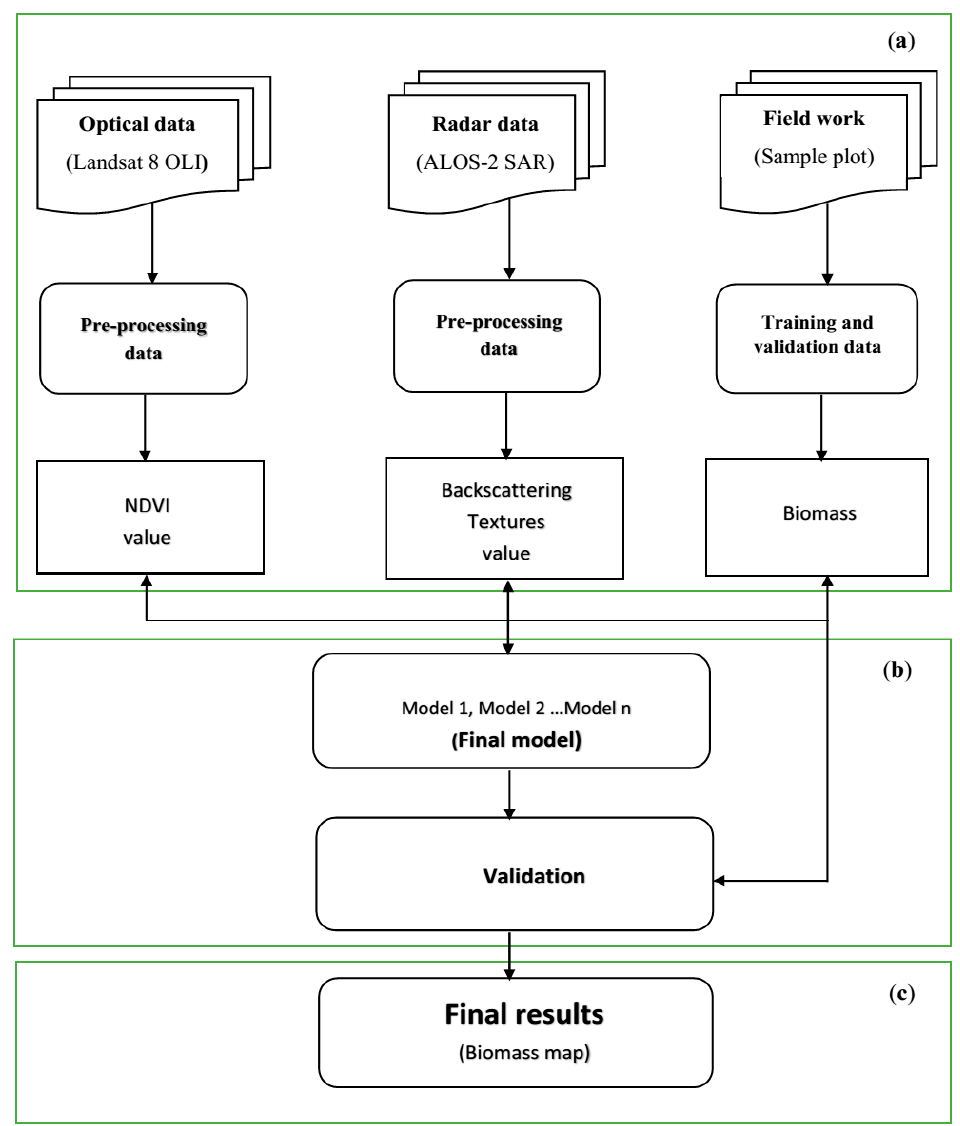
Figure 2. Flowchart describing the methodology of this study: ( a ) pre-processing, ( b ) modeling, and ( c ) mapping.